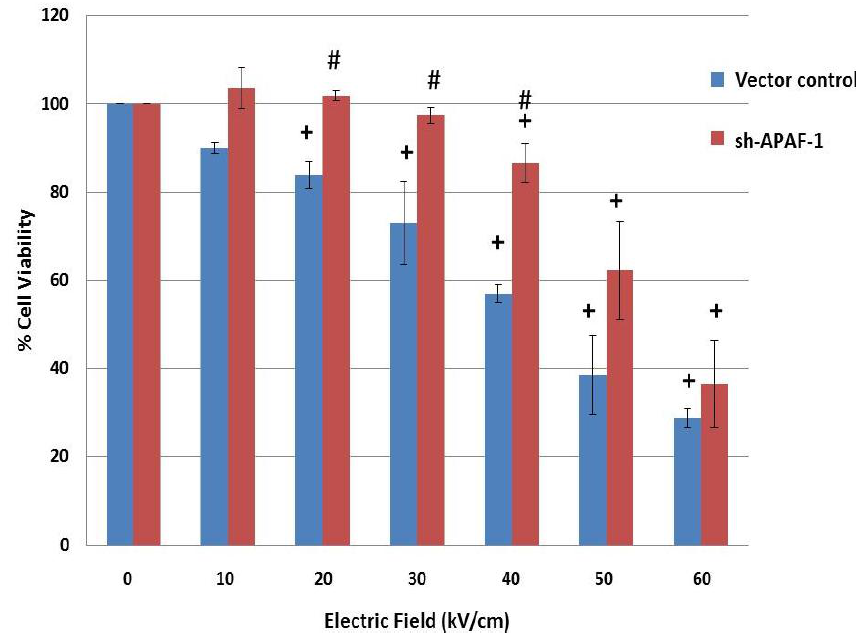
Figure 7. NsPEF-induced cell death is caspase-dependent at lower electric fields (20 (cid:177) 40 kV/cm) and caspase-independent at (cid:75)(cid:76)(cid:74)(cid:75)(cid:72)(cid:85)(cid:3)(cid:72)(cid:79)(cid:72)(cid:70)(cid:87)(cid:85)(cid:76)(cid:70)(cid:3)(cid:73)(cid:76)(cid:72)(cid:79)(cid:71)(cid:86)(cid:3)(cid:11)(cid:149)(cid:3)(cid:24)(cid:19)(cid:3)(cid:78)(cid:57)(cid:18)(cid:70)(cid:80)(cid:12)(cid:3) at in Jurkat cells: A Jurkat clone deficient in APAF-1 and its vector control were tested with ten 60 ns pulses with increasing electric fields. Cell viability was determined 24 hours later - as described in the Experimental section. The same results were obtained with the MTS assay. For statistical significance: + p< 0.05 vs. sham control (0 kV/cm); # p< 0.05 vector control clone vs. sh-APAF-1 clone; (n = 3). These data have been previously published in a different format